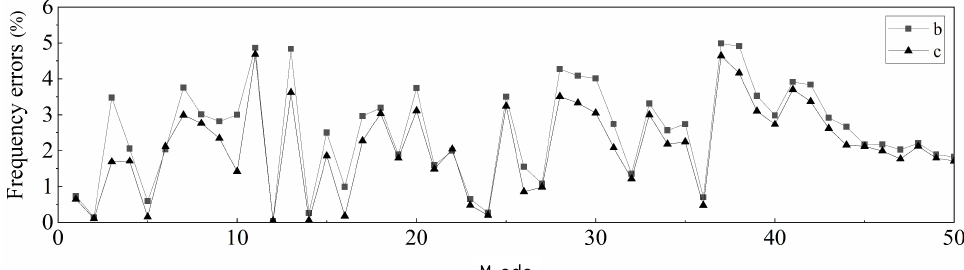
Mode Figure 15. Relative errors (%) of the first fifty natural frequencies for Scheme b and